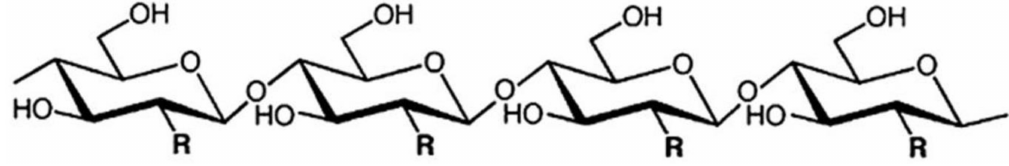
Figure 4. Chemical structure of cellulose, where R = OH [48]. Reproduced with permission from ref. [48]. Copyright American Chemical Society,